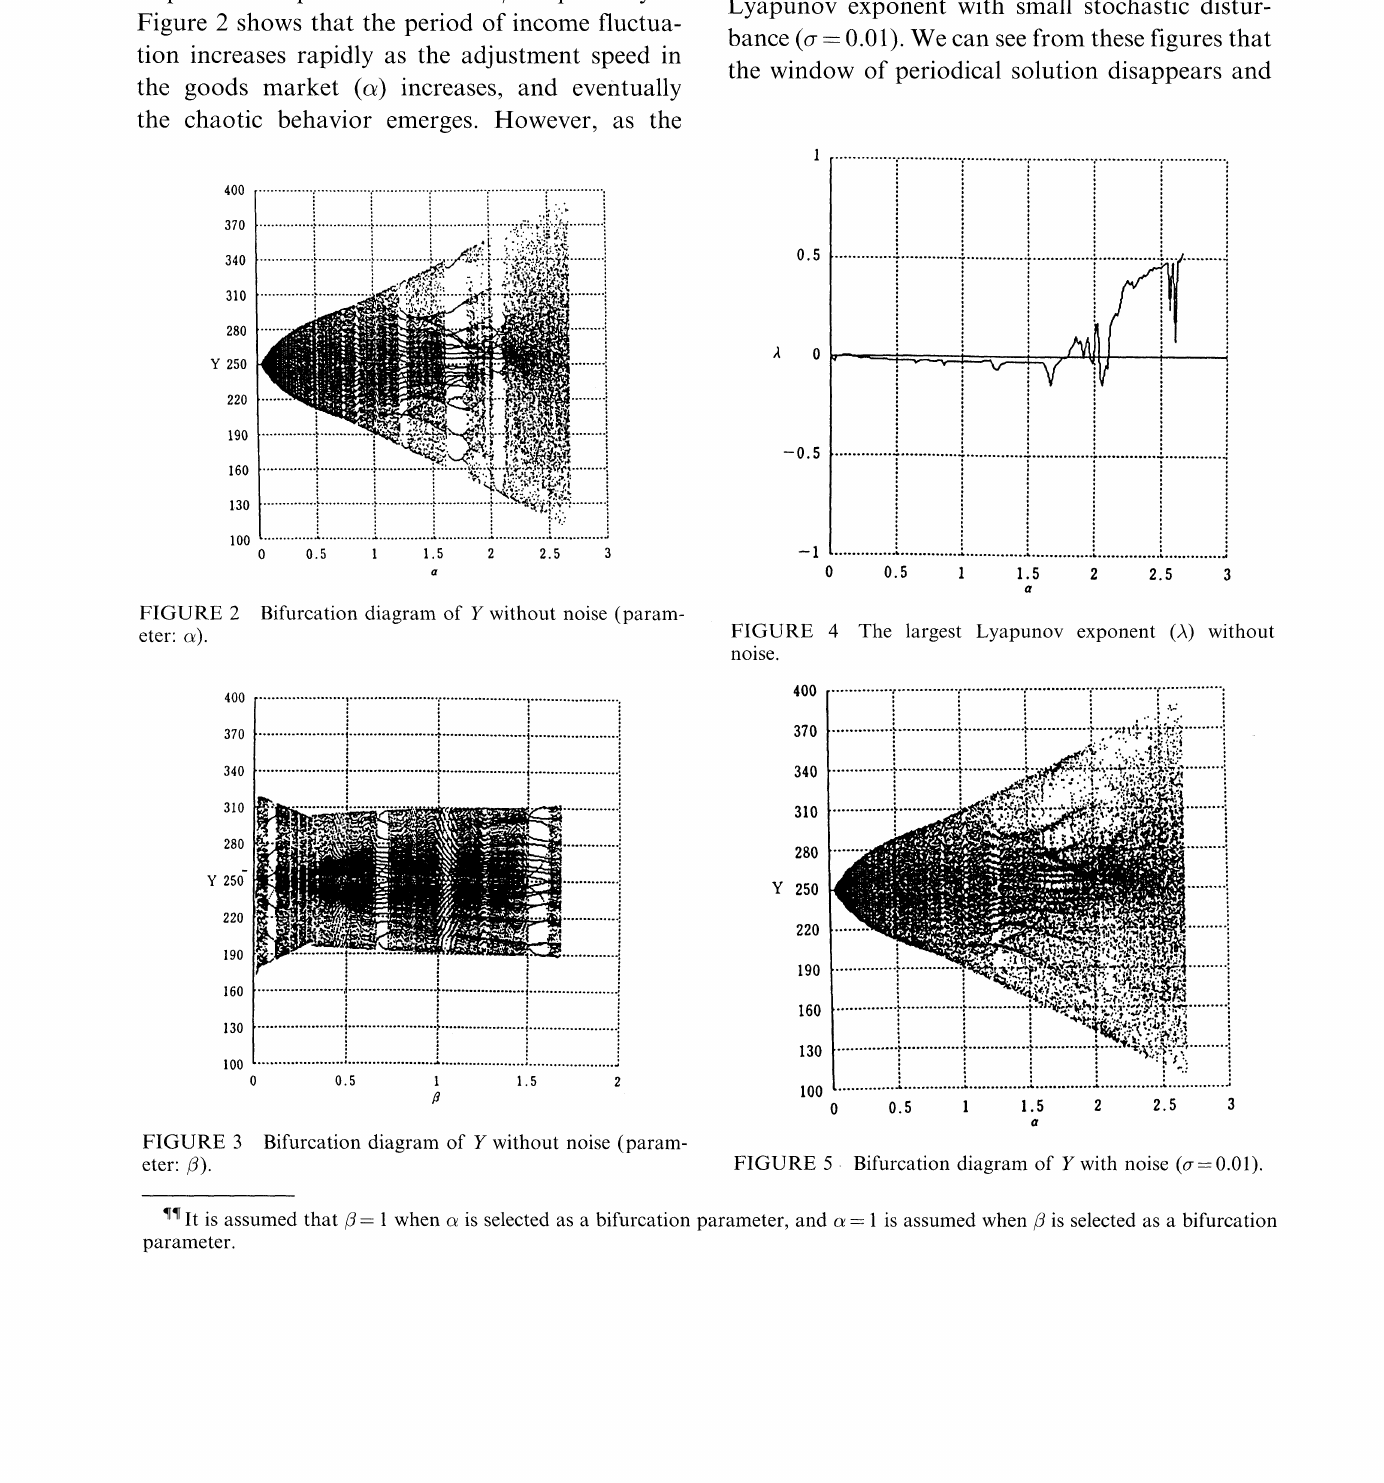
FIGURE 2 Bifurcation diagram of Y without noise (param- eter: c). FIGURE 4 The largest Lyapunov exponent (A) without